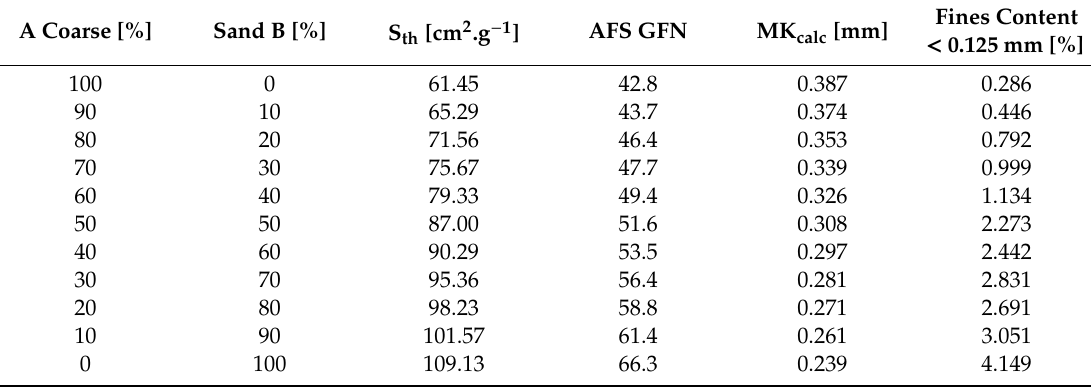
Table 3. Basic properties of sands A coarse and